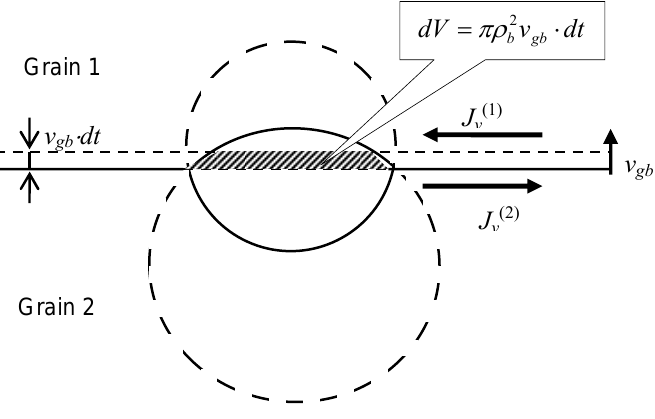
Figure 3. Determination of vacancy fluxes along the grain boundary in two adjacent grains providing relocation of a lenticular bubble coherently with the grain